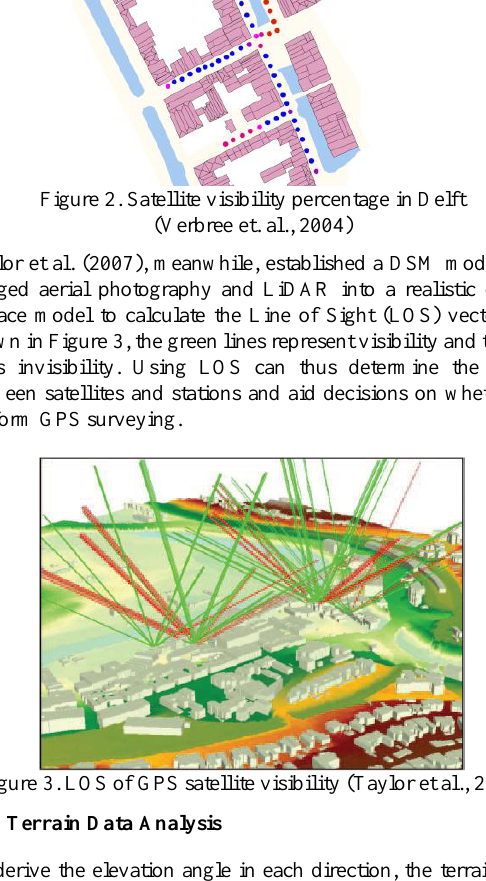
To derive the elevation angle in each direction, the terrain data must first be processed. The two most commonly used data in terrain analysis are raster data and vector